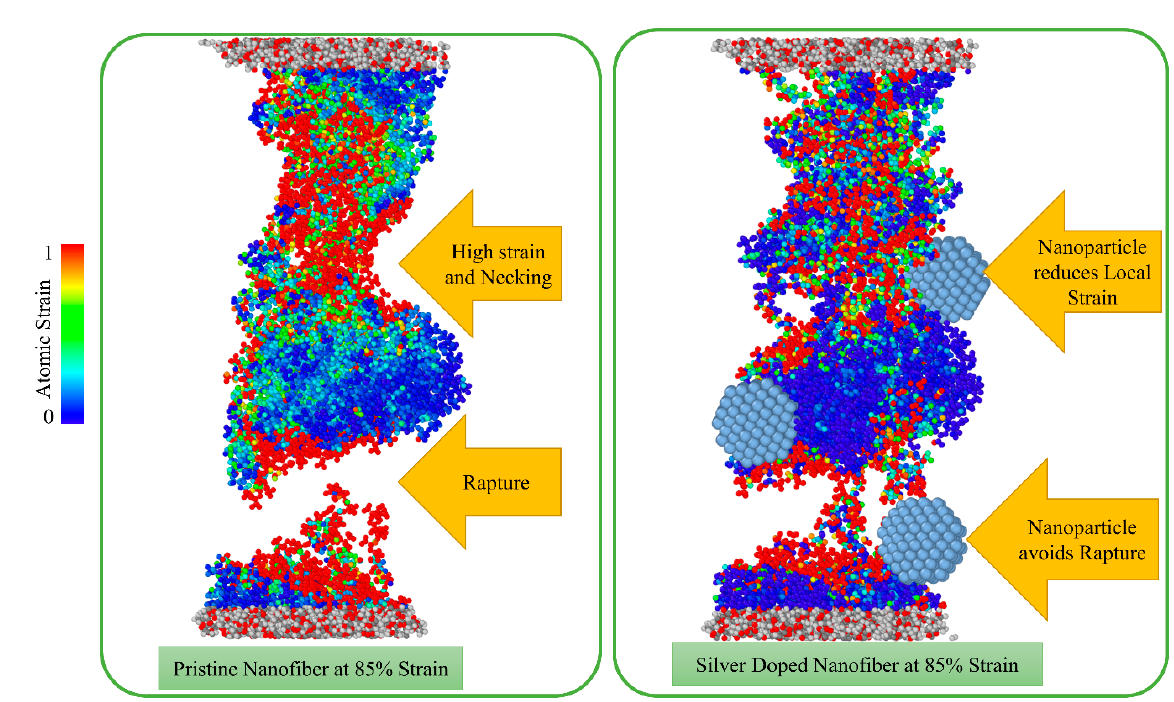
Figure 10. The effective role of doping nanoparticles on fracture resistance of nanofibres.